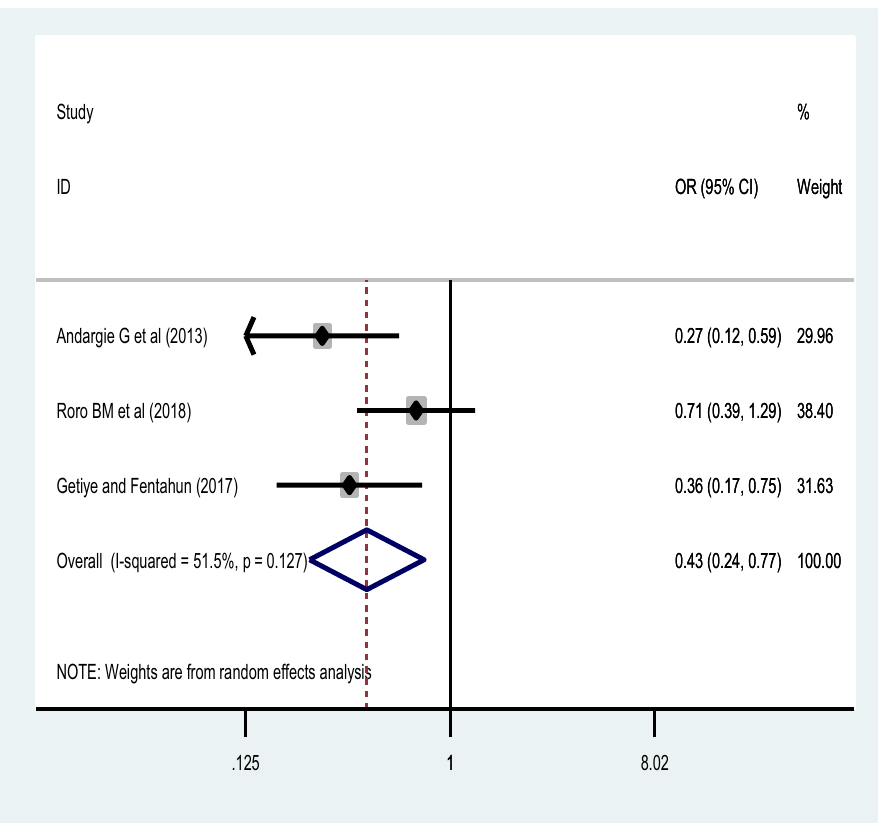
Figure 6. Association of maternal tetanus toxoid immunization on perinatal mortality